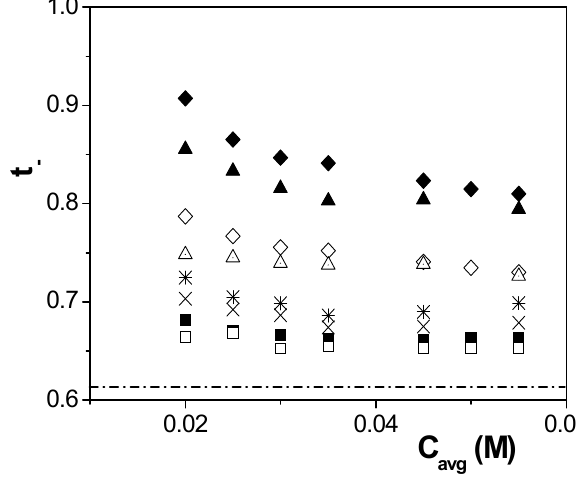
O (▲, ∆); and Al-Ox/SiO ( * , 2 3 2